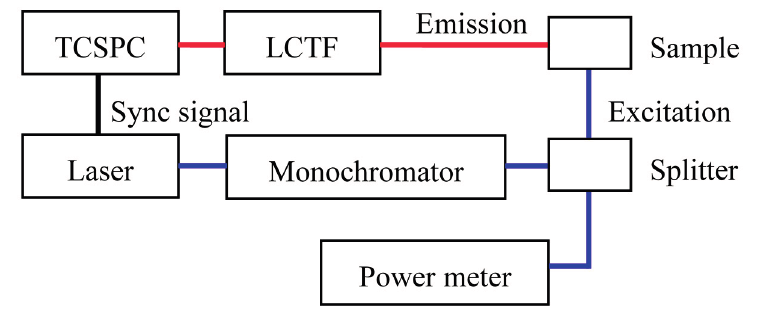
Figure 3. Schematic of the time-resolved synchronous fluorescence (TRSF)